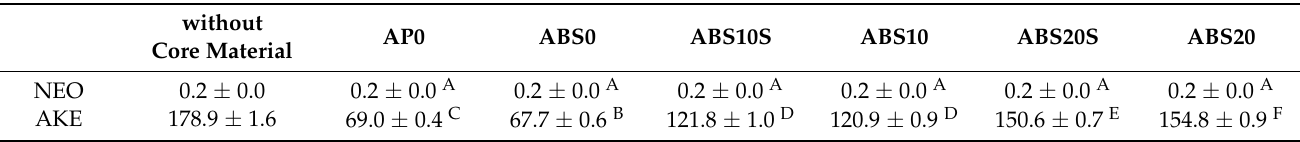
Table 4. Air flow rates of various specimens obtained from air permeability test. The values of the same letter were not significantly different ( p > 0.05).